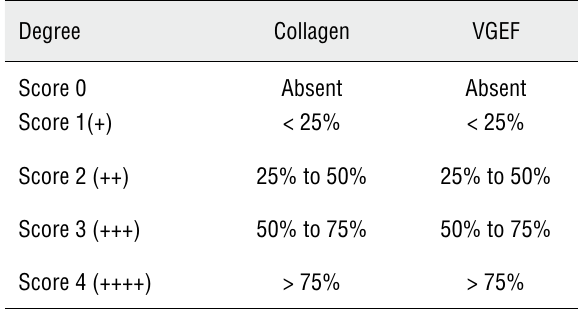
Table 1 - Semi-quantitative scores: percentage of collagen deposition and vEGF expression.